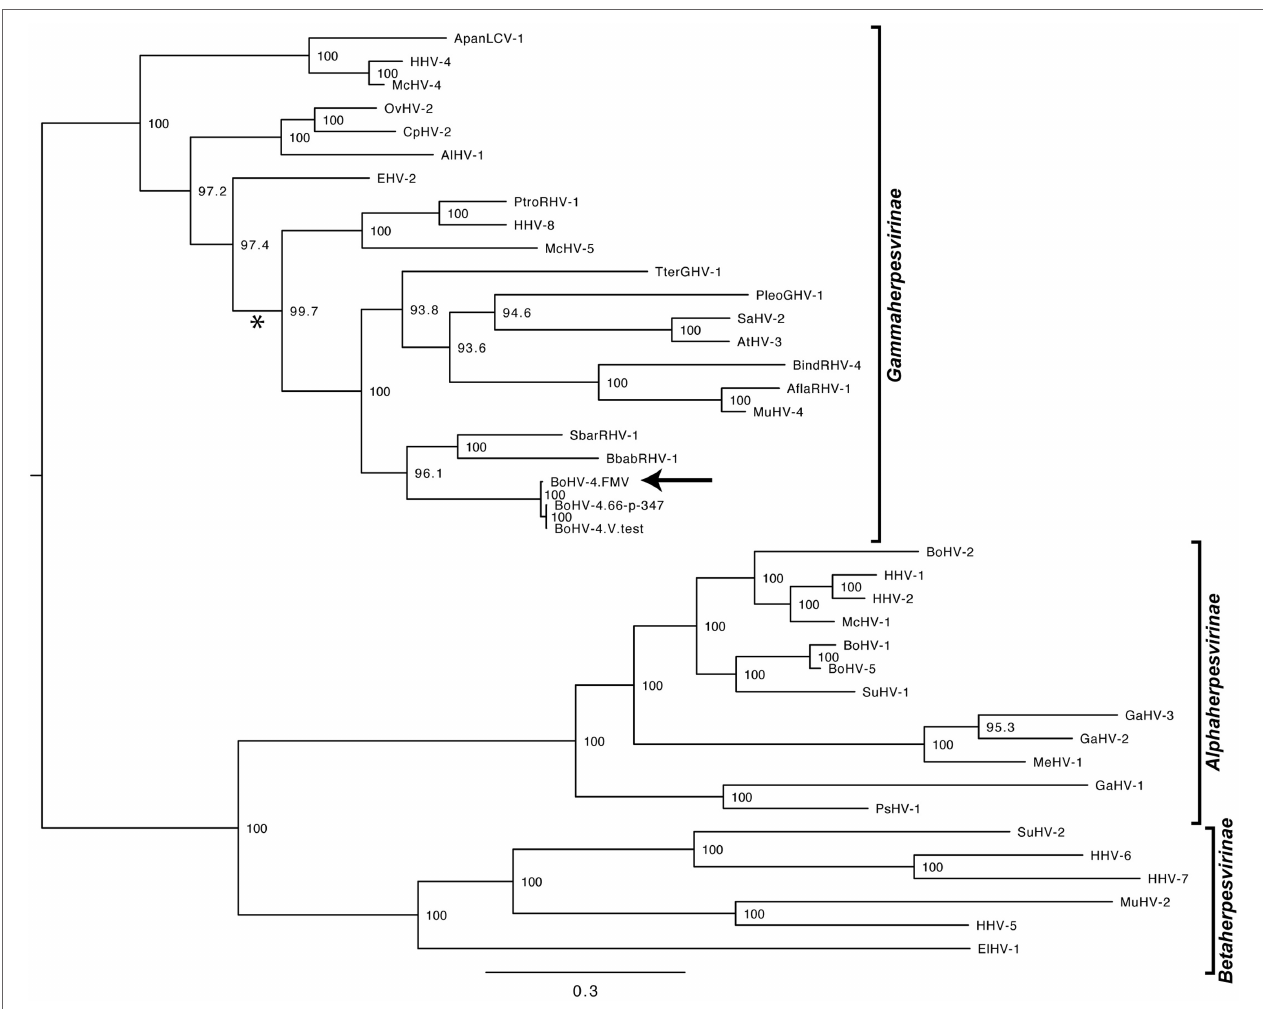
FigUre 3 | Molecular phylogeny of the DNA polymerase (DPOL) gene of various herpesvirus species. The phylogeny of DPOL gene sequences (1555 nucleotides in length) from 40 herpesviruses (Table S1 in Supplementary Material) was determined using MrBayes programs. Numbers on branches correspond to posterior probabilities. Branch length is proportional to the number of nucleotides substitutions. The tree is unrooted. The arrow points to the bovine gammaherpesvirus 4 (BoHV-4)-FMV strain and the asterisk (*) highlights the Rhadinovirus genus